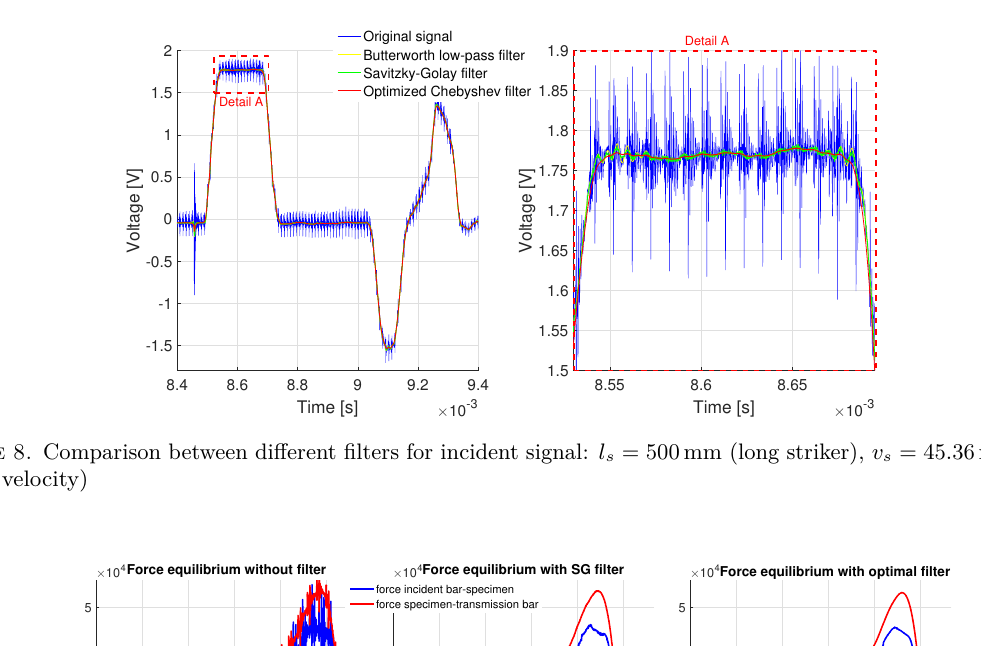
s = 500 mm (long striker), v s = 45 . 36 ms